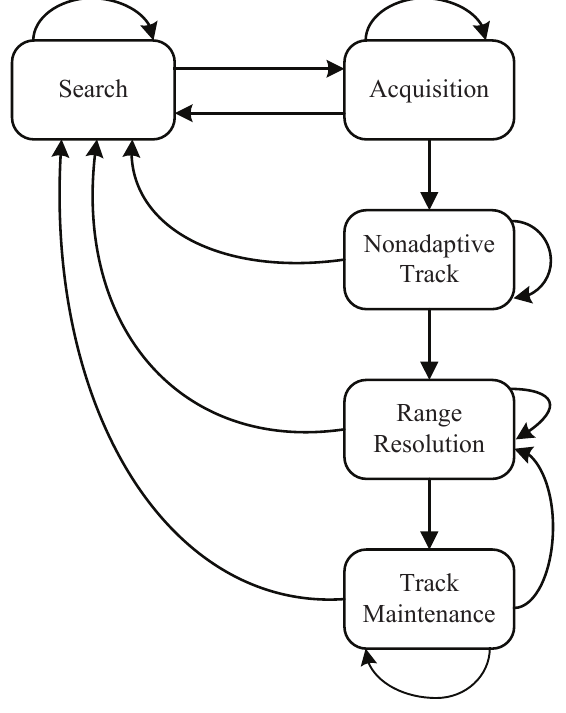
Figure 6. State transition of the Mercury radar. Table 1. List of all Mercury radar phrase combinations according to the functional states of the radar.